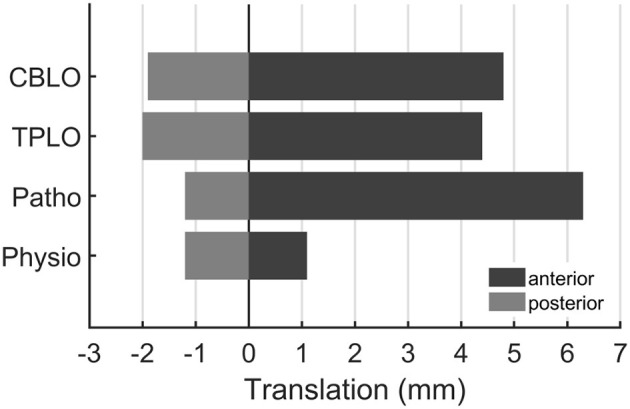
Anterior and posterior translations of the tibia relative to the femur, resulting from the drawer test simulation, performed on all models: CBLO-treated (CBLO), TPLO-treated (TPLO), Pathological (Patho), and Physiological (Physio). The vertical zero line is the equilibrium position reached by each model before the application of the AP drawer force.